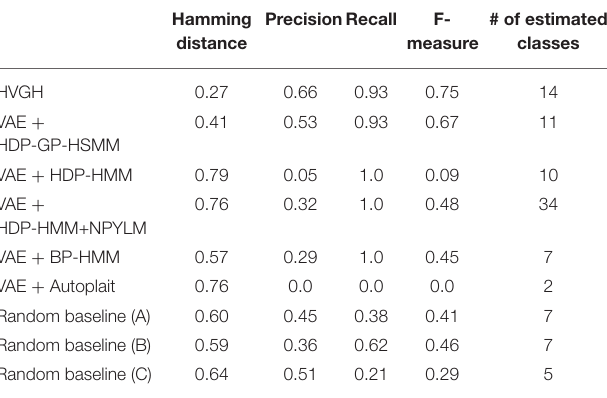
TABLE 3 | Segmentation results for the exercise motion 1: subject